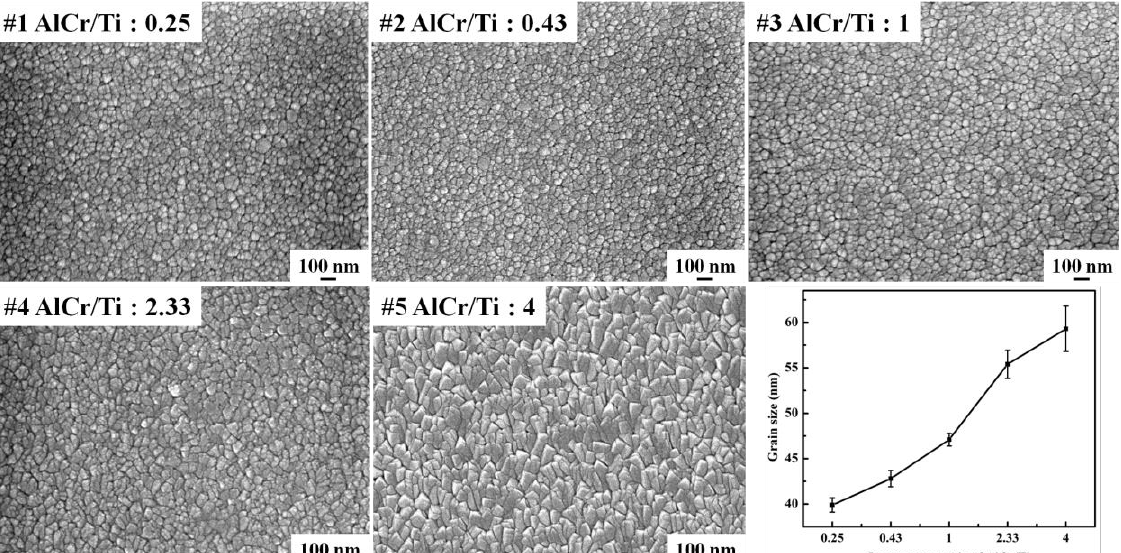
Figure 3. Top-view SEM images of the AlTiCrN coatings deposited under five different input power ratios.